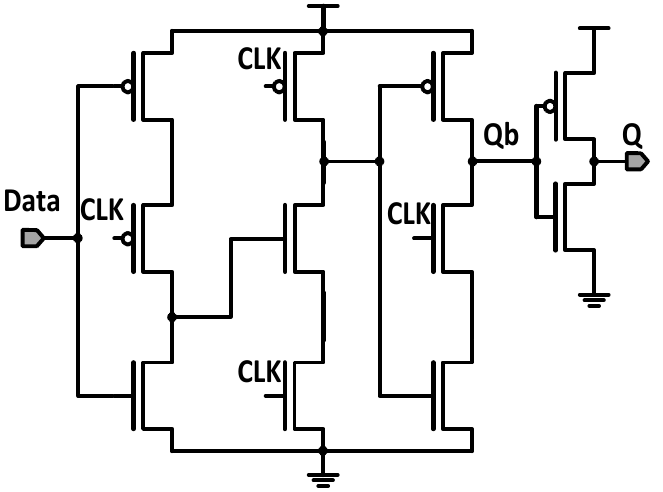
Figure 2. True Single Phase Clock Flip-Flop (TSPCFF).